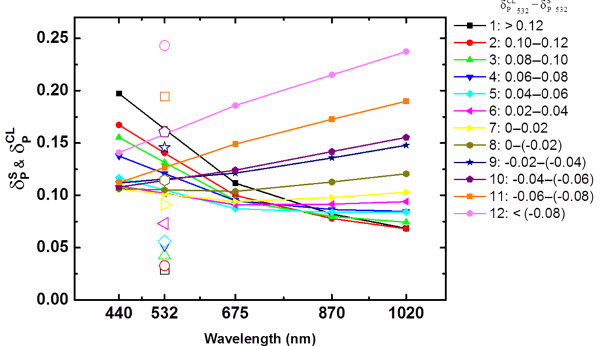
Figure 5. The average values of δ S at five wavelengths (440, 532, P 670, 875, and 1020nm) and δ CL at 532nm divided by the range Figure 6. The average value of the volume size distributions de- P − δ S of the differences between δ S and δ CL at 532nm ( δ CL ). rived by AERONET sun–sky radiometer measurements divided P P P , 532 P , 532 by the range of the differences between δ S The symbol of δ CL at 532nm is shown as open figure and in larger P − δ S size. ( δ CL P , 532 P , 532